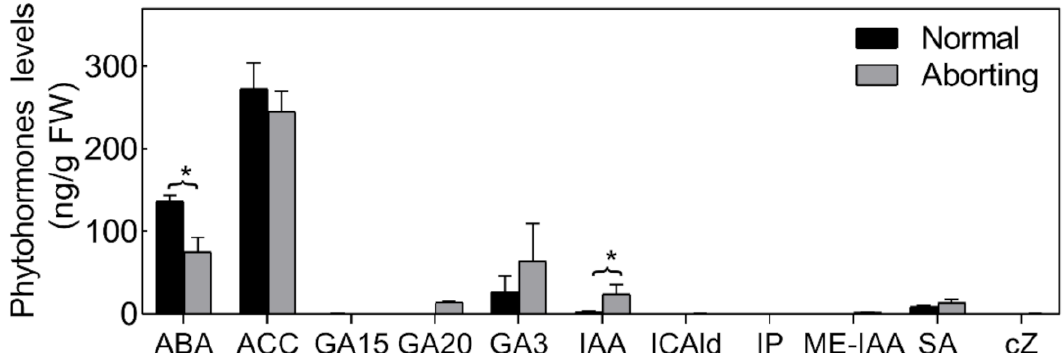
Figure 3. Endogenous hormone proles of normal and aborting flower buds. After growing for 2 months, 2- to 3-m long normal or aborting flower buds were excised for phytohormone or biosynthetic intermediates content analysis. Content of abscisic acid (ABA), 1-Aminocyclopropanecarboxylic acid (ACC), salicylic acid (SA), gibberellin A15 (GA15), GA20, GA3, auxin, indole-3-acetic acid (IAA), methyl indole-3-acetate (ME-IAA), Indole-3-carboxaldehyde (ICAld), N6- isopentenyladenine (IP), and cis-zeatin (cZ) were analyzed. Values are the means ± SE of three independent experiments with at least three replicates for each. Bars with asterisks were significantly different in comparison with normal buds at * p < 0.05, according to the t